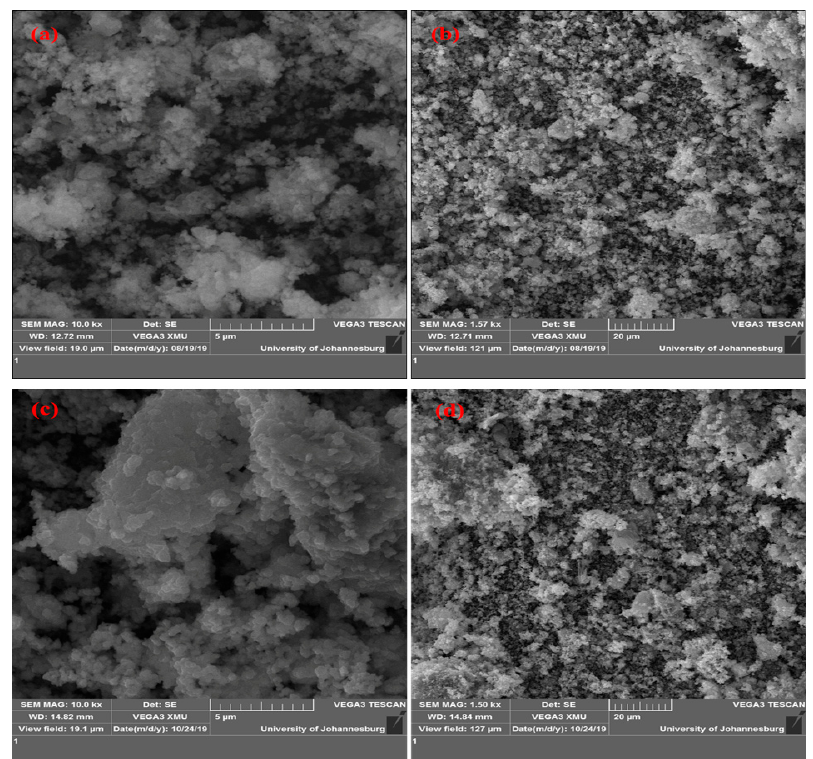
Figure 4. SEM images of prepared NiMo/CaTiO 3 catalysts containing different CaTiO 3 content: ( a , b ) NMC412, ( c , d ) NMC414.